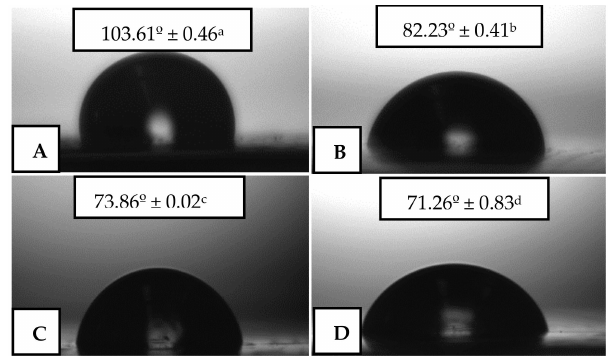
Figure 5. Water contact angle of the electrospun films of: ( A ) Neat poly(3-hydroxybutyrate- co -3- hydroxyvalerate) (PHBV); ( B ) Oregano essential oil (OEO)-containing PHBV; ( C ) Rosemary extract (RE)-containing PHBV; ( D ) Green tea tree extract (GTE)-containing